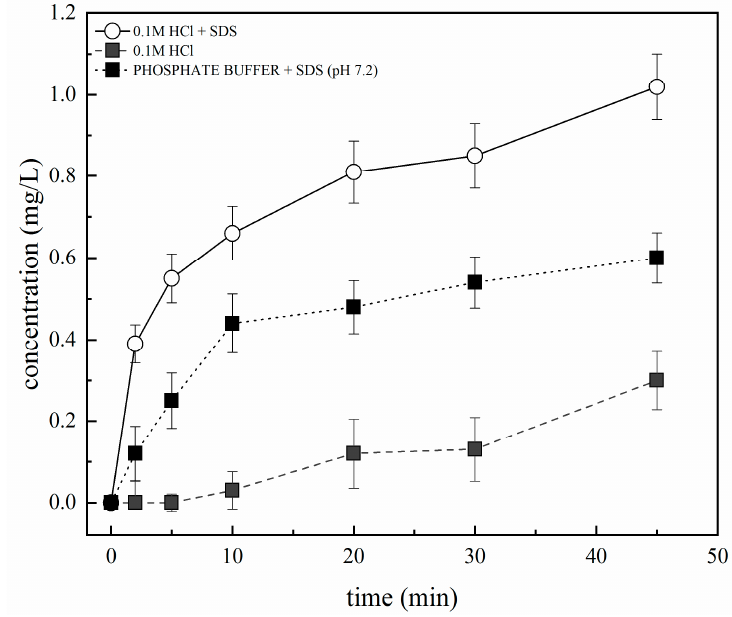
Figure 7. Solubility testing of TAD in various dissolution media.